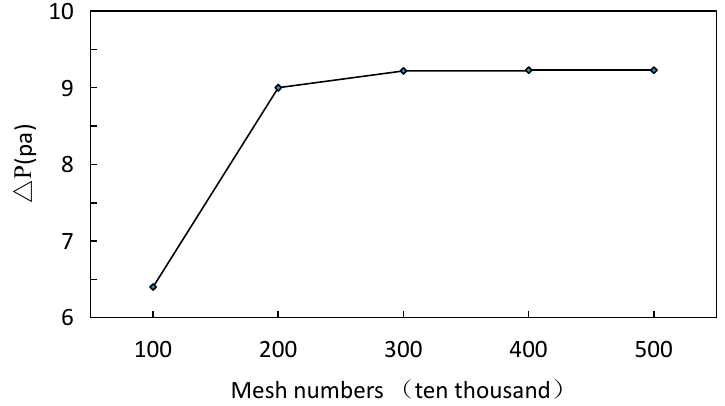
Figure 3. Grid independency check for Scheme.